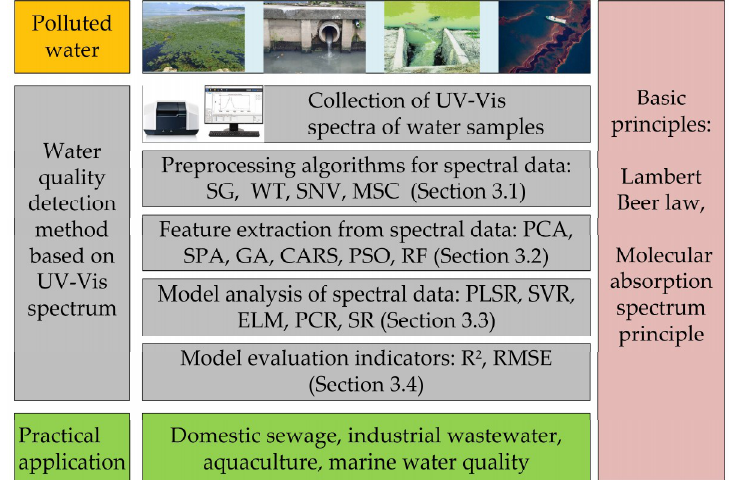
Figure 2. Steps for determining water quality parameters based on UV-Vis spectroscopy (Note: The polluted water from left to right is eutrophication water body, factory sewage, domestic wastewater and marine pollution. The instrument used to collect spectral data is UV-2450. Savitzky–Golay smooth filter (SG), Wavelet transform (WT), Standard normal variate (SNV), Multiple scattering correction (MSC), Principal component analysis (PCA), Successive projections algorithm (SPA), Genetic algorithm (GA), Competitive adaptive reweighted sampling (CARS), Particle swarm optimization (PSO), Random frog (RF) algorithm, Partial least squares regression (PLSR), Support vector machine regression (SVR), Extreme learning machine (ELM) model, Principal component regression (PCR), and Stepwise regression (SR).